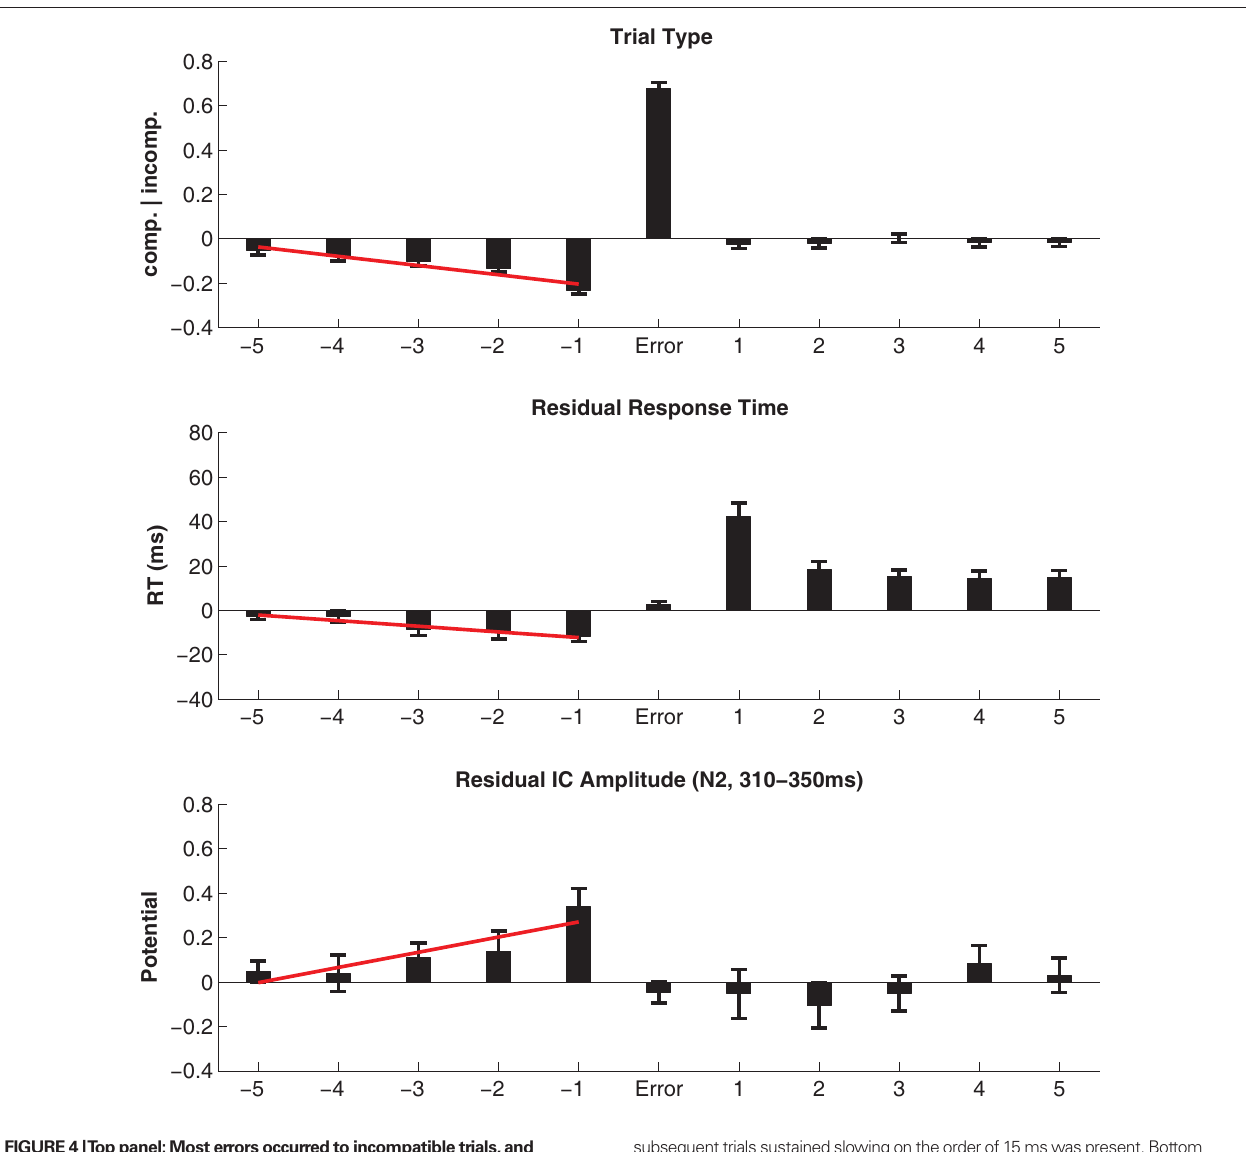
FiGurE 4 | Top panel: Most errors occurred to incompatible trials, and error-preceding trials showed an increased frequency of compatible trials. Following errors, the probability of compatible/incompatible outcomes is equal (as it is across the entire experiment). Middle panel: Residual RTs were on average 11 ms faster in trials immediately prior to errors and were speeding by 2.5 ms per trial from − 5 to − 1. Post-error slowing of responses by 42 ms was observed and in